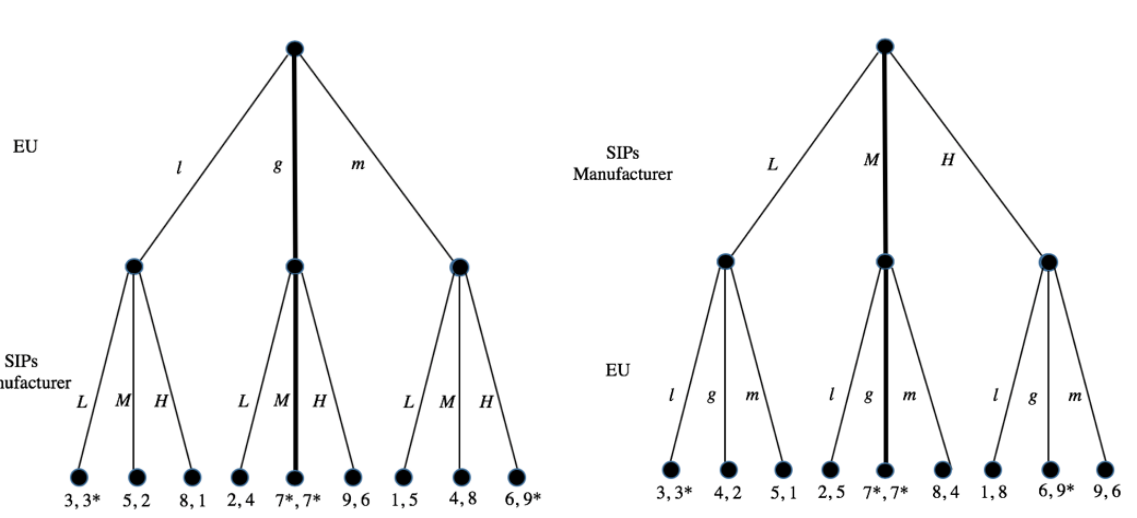
Figure 7. Sequential Timing.